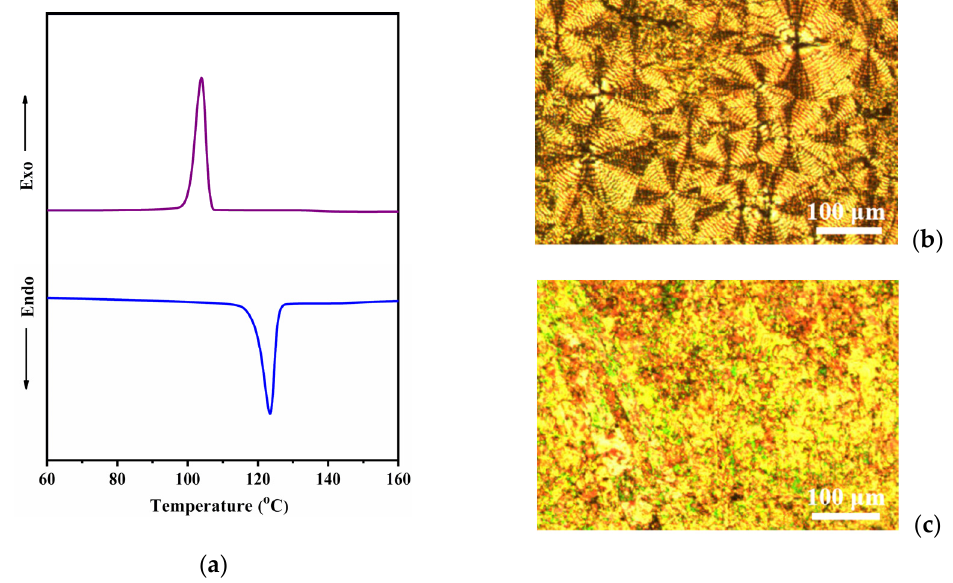
Figure 1. ( a ) Differential scanning calorimetry (DSC) thermogram of M1 at 10 °C/min during the first cooling process and the second heating process; polarized optical microscopy (POM) of the compound M1 at ( b ) 50 °C, ( c ) 150 °C during the heating (magnification: